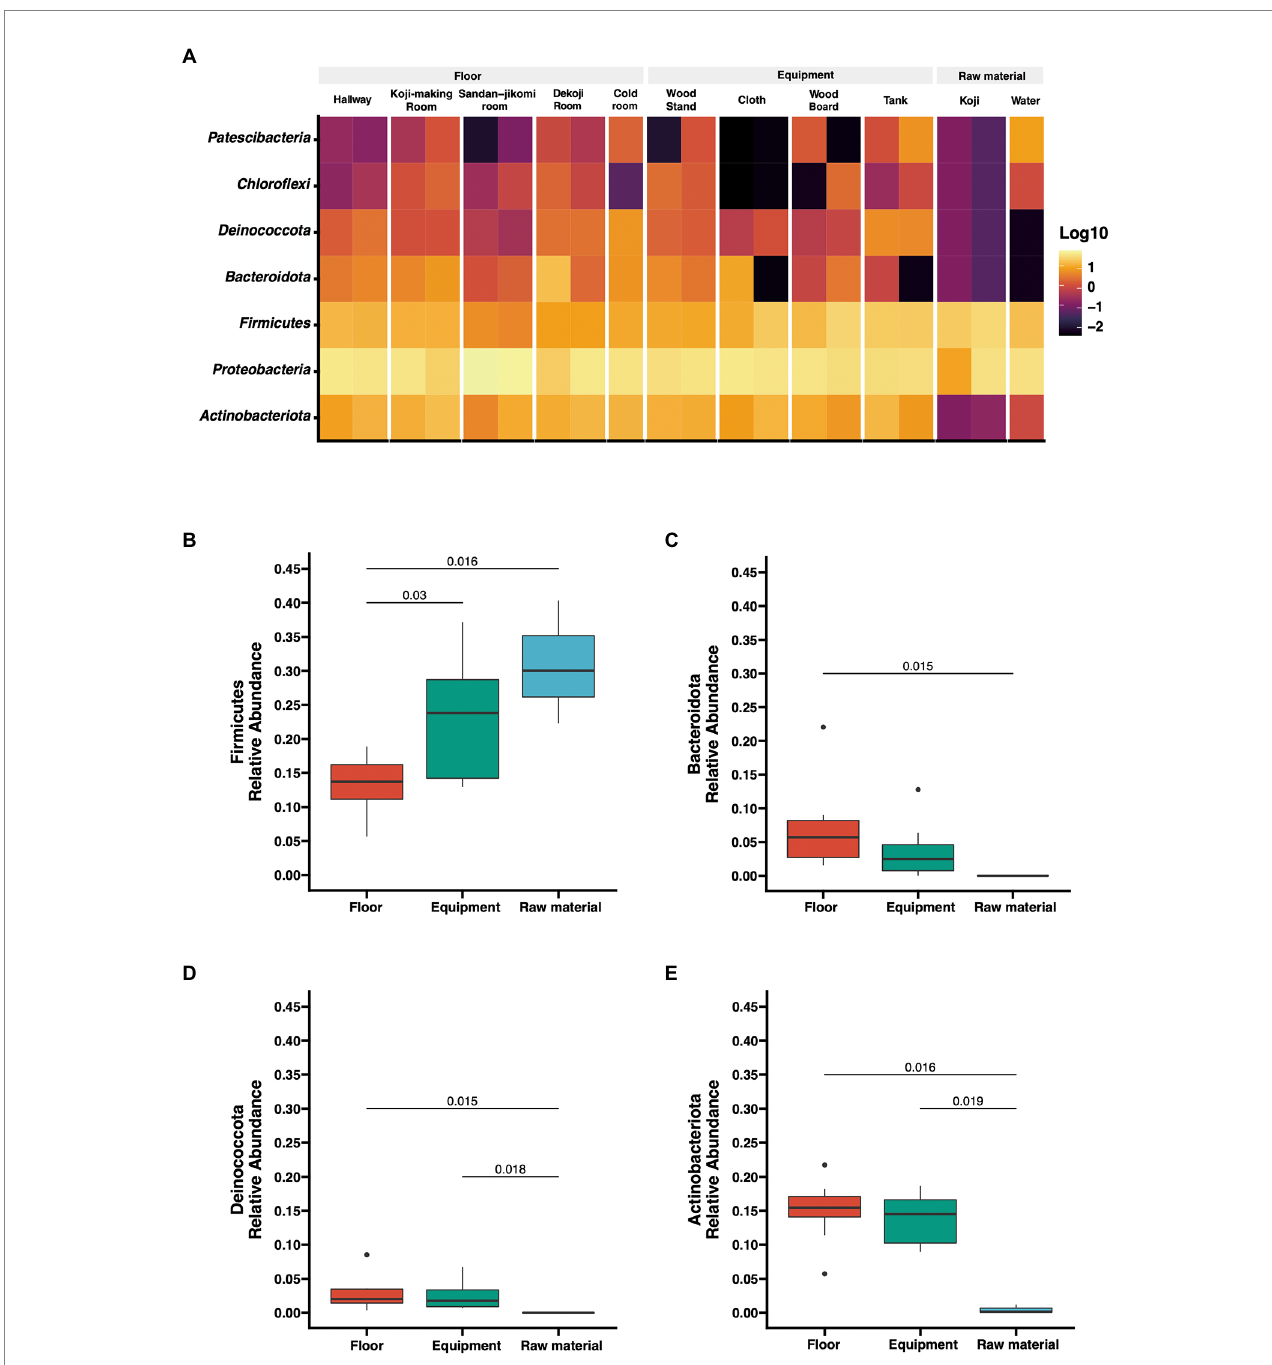
FIGURE 2 (A) Taxon abundance heatmap at the phylum level. Heatmap depicts the relative abundances (log10 scale) of the top 7 phyla across all surfaces. (B–E) Box plot representation for phylum-level comparison among each group. Four phyla ( Firmicutes , Bacteroidota , Deinococcota , Actinobacteriota ) were compared across groups in the brewery. Statistical analysis was computed using Mann- U